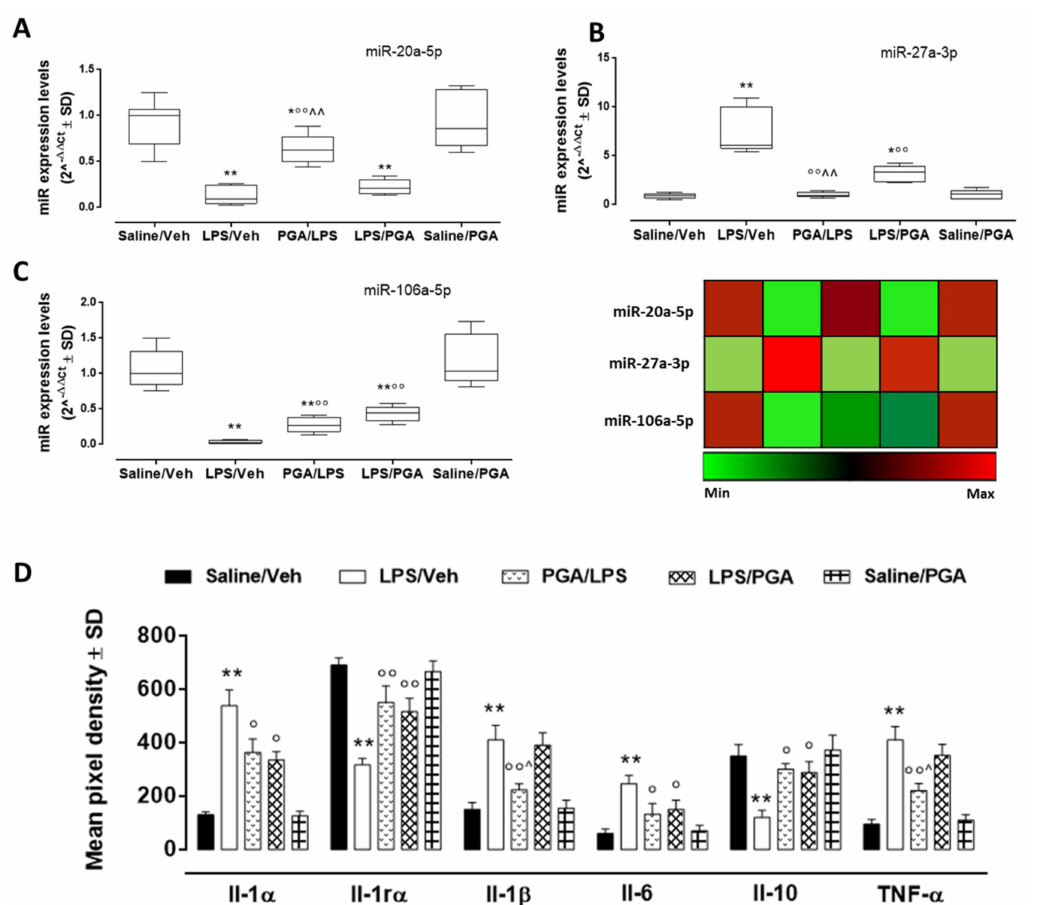
Figure 3. Dysregulated miRNA ( A – C ) and interleukin corneal levels ( D ). miR-20a-5p, miR-27a-3p and miR-106a expression levels, reported as median 2ˆ − ∆∆ Ct ± SD and depicted according to the color scale (red: upregulation; green: downreg- ulation). Interleukins levels were reported as mean pixel density ± SD. Statistical significance was assessed by one-way ANOVA, followed by Tukey’s multiple comparison test of N = 3 measurements for each individual/group. Saline/Veh = mice receiving intrastromal injection of 2 µ L PBS; PGA/LPS = mice administered with PGA 5 mg/kg per os 30 min before LPS intrastromal injection; LPS/Veh = mice receiving intrastromal injection of 2 µ g LPS dissolved in 2 µ L PBS; LPS/PGA = mice consecutively administered for three days with PGA 5 mg/kg per os , starting from 30 min after LPS intrastromal injection; Saline/PGA mice consecutively administered for three days with PGA 5 mg/kg per os , starting from 30 min after PBS intrastromal injection. * p < 0.05 and ** p < 0.01 vs. Saline/Veh; ◦ p < 0.05 and ◦◦ p < 0.01 vs. LPS/Veh; ˆ p < 0.05 and ˆˆ p < 0.01 vs.